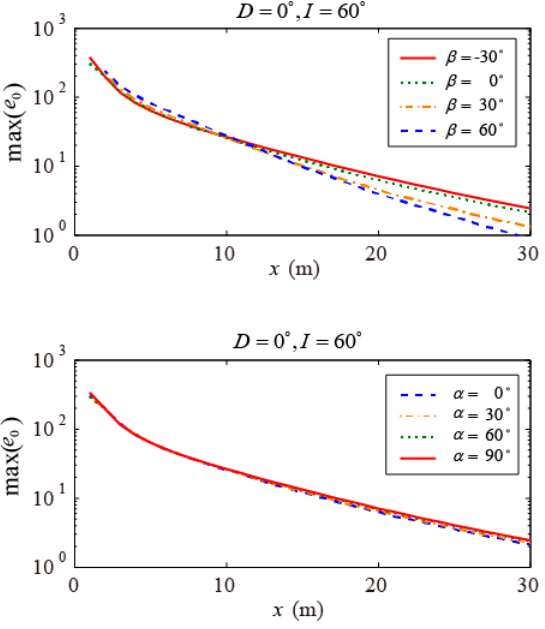
Figure 5. Maximum values of MRS signals with varying coil directions for a 1-m-thick aquifer with a water content of 100% located at varying distances